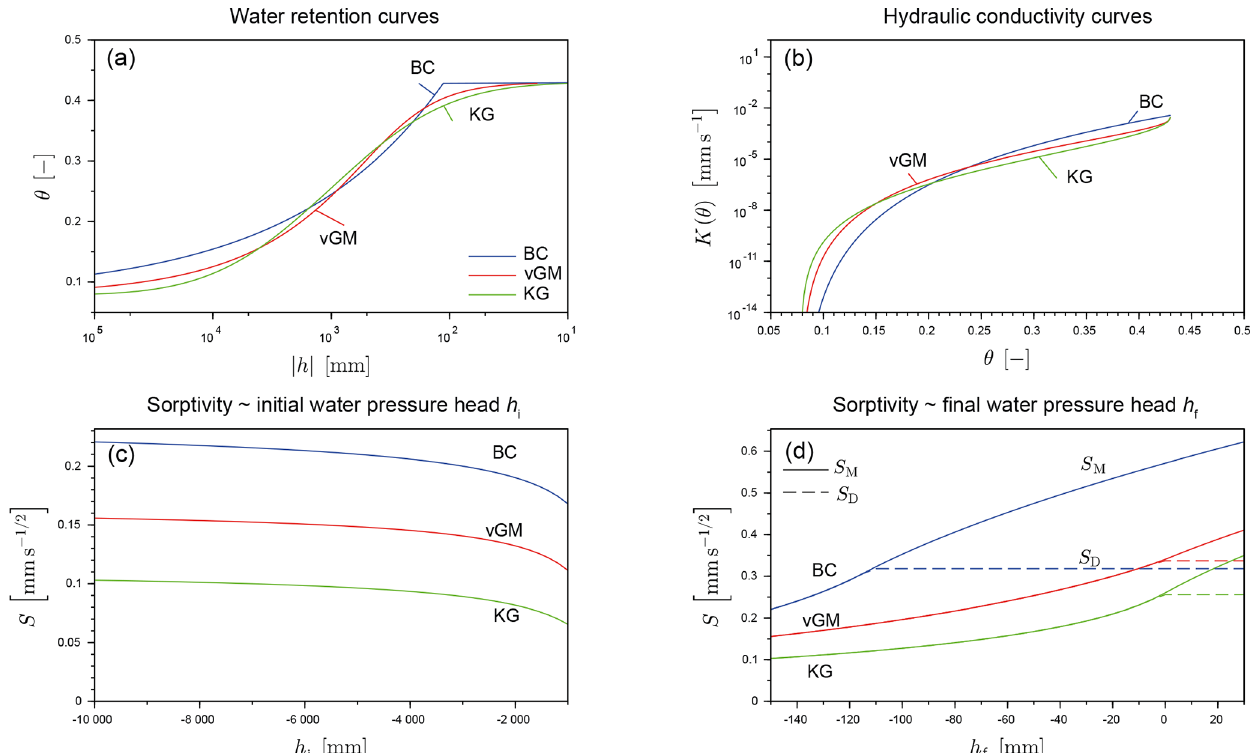
Figure 7. Water retention (a) and hydraulic conductivity (b) curves described by the three sets of hydraulic models (BC, vGM, and KG) and sorptivity as a function of initial (c) and final (d) water pressure heads with the sorptivity estimated by the proposed mixed formulation S M and the regular model S D